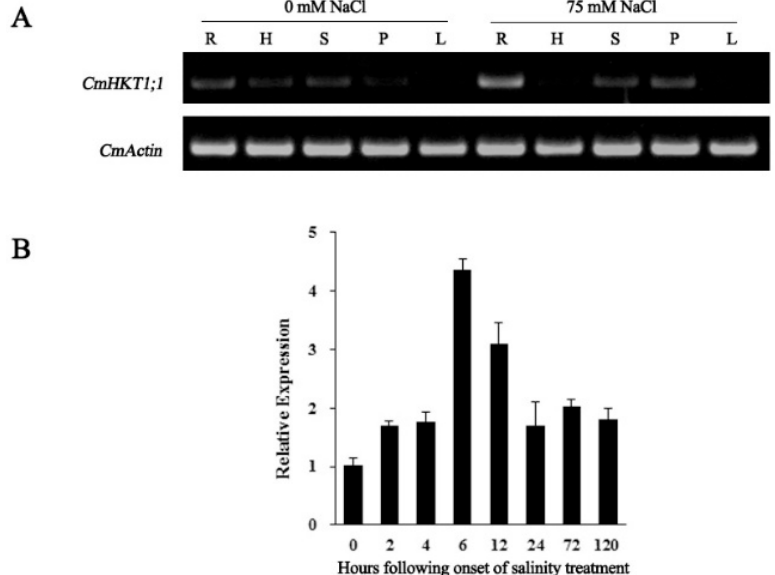
Figure 3. Expression pattern of CmHKT1;1 in pumpkin under salinity stress. ( A ) RT-PCR analysis of CmHKT1;1 expression in pumpkin. RNA was extracted from the root (R), hypocotyl (H), stem (S), petiole (P), and leaf (L) of the plants after 24 h of 75 mM salt treatment, and the reverse transcription products were amplified. CmHKT1;1 expression in plants without NaCl was used as control. ( B ) Time-course expression analysis of CmHKT1;1 in response to NaCl (75 mM) treatment by qRT-PCR in pumpkin roots. The Actin gene was used as the internal control. Error bars represent SE ( n = 3).